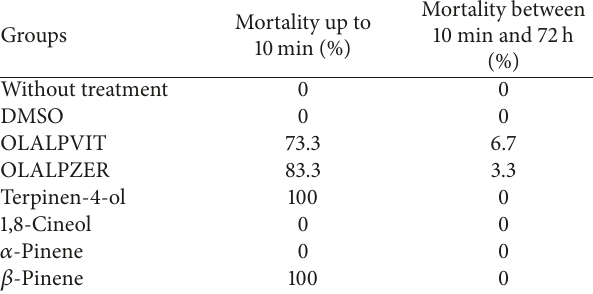
Table 4: Mortality of R. nasutus fifth-instar nymphs treated with OLALPVIT, OLALPZER (125 𝜇 g/ 𝜇 L), and their main constituents, terpinen-4-ol (25 𝜇 g/ 𝜇 L), 1,8-cineol (19 𝜇 g/ 𝜇 L), 𝛼 -pinene (12.5 𝜇 g/ 𝜇 L), and 𝛽 -pinene (44 𝜇 g/ 𝜇